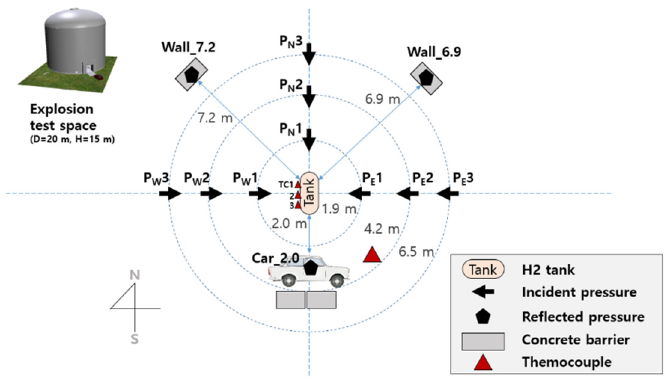
Figure 1. Schematic of experimental setup.